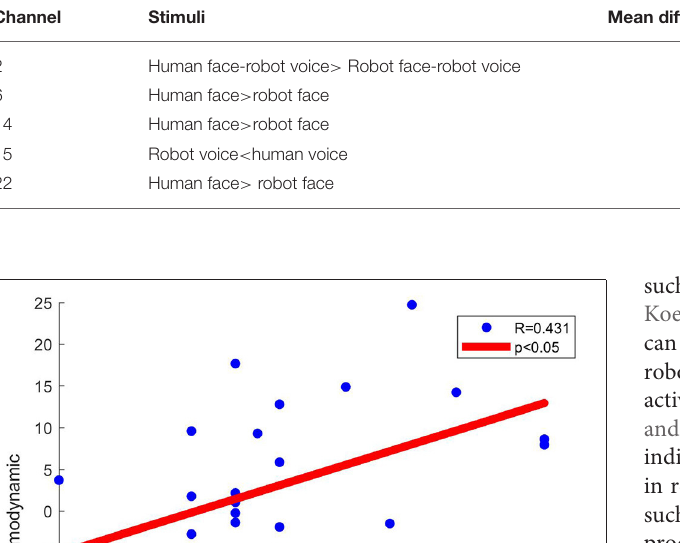
TABLE 2 | Post-hoc comparisons of Cohen’s D metric obtained during different types of stimuli at the significant channels. Channel